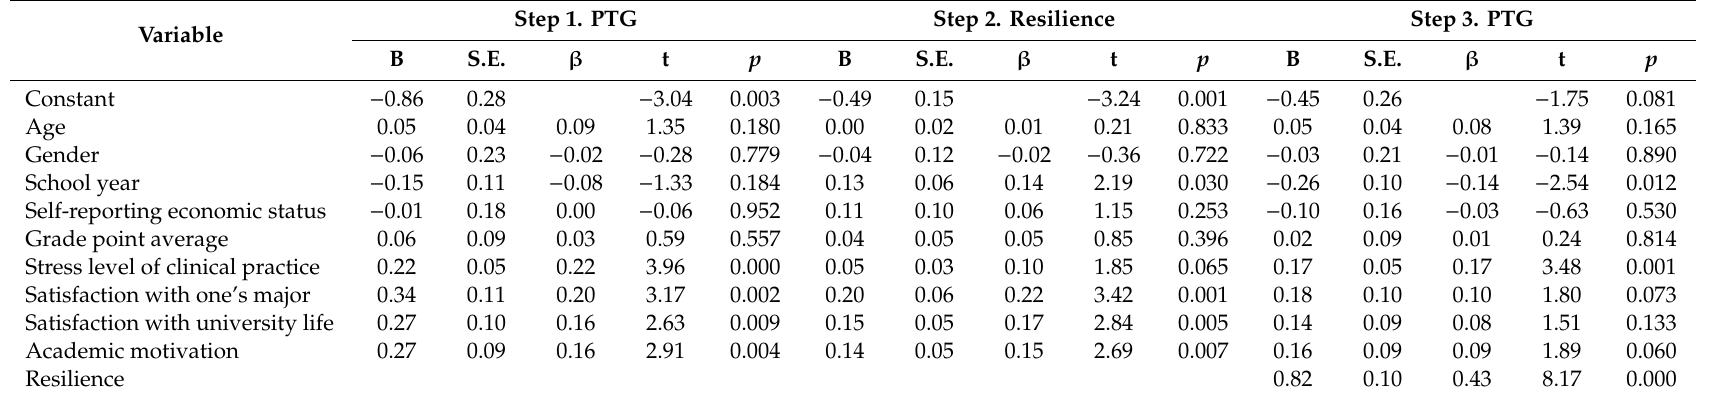
Table 3. Mediating e ff ect of